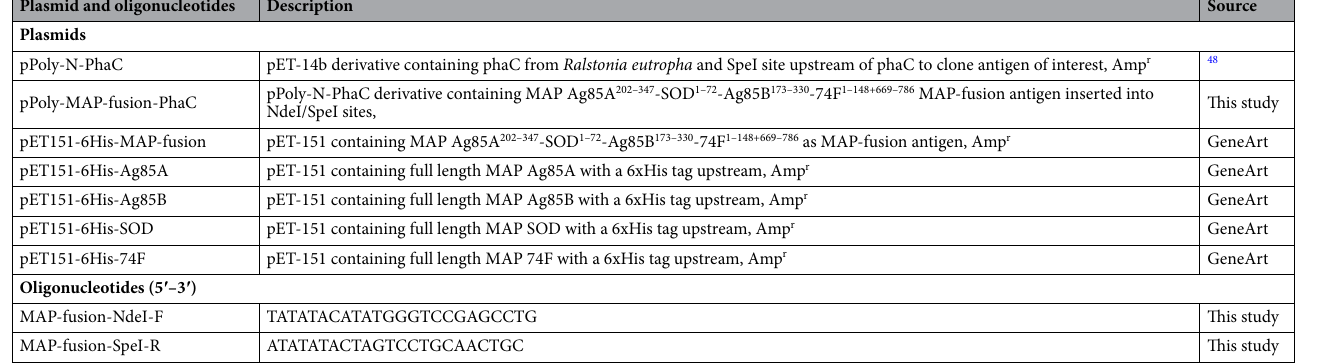
Table 1. Plasmids and oligonucleotides used in the present